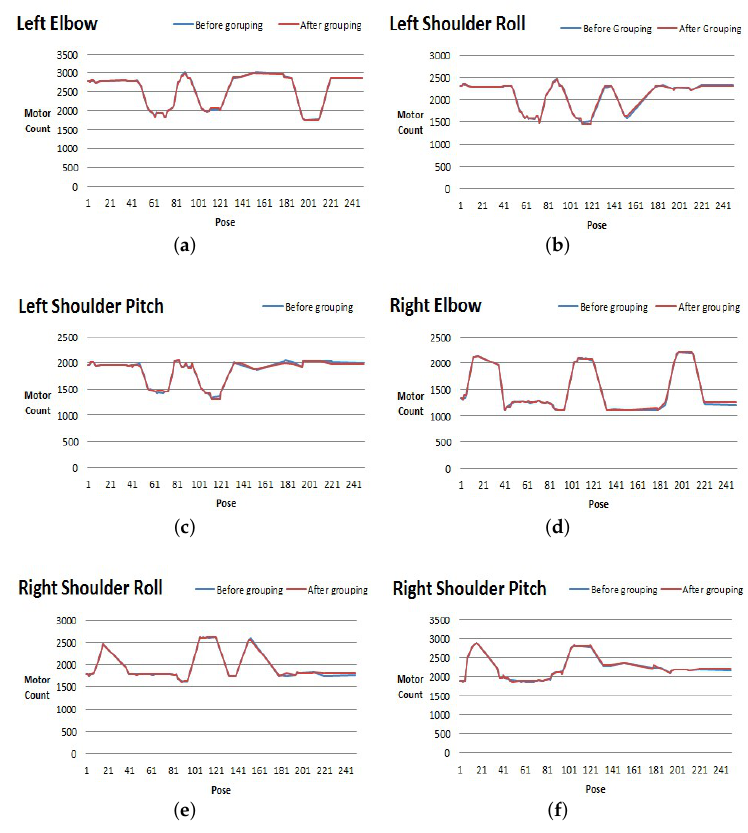
Figure 12. ( a ) Motor counts data on Left Elbow. ( b ) Motor counts data on Left Shoulder Roll. ( c ) Motor counts data on Left Shoulder Pitch. ( d ) Motor counts data on Right Elbow. ( e ) Motor counts data on Right Shoulder Roll . ( f ) Motor counts data on Right Shoulder Pitch.